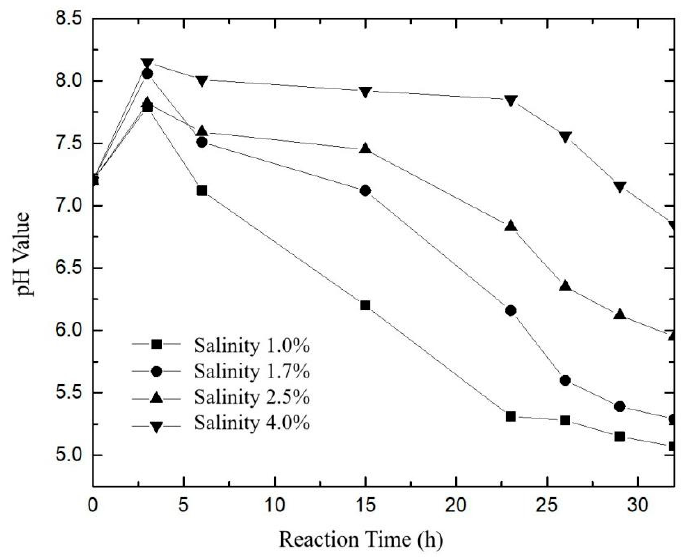
Figure 7. Effect of salinity on the pH Value by aerobic sludge.